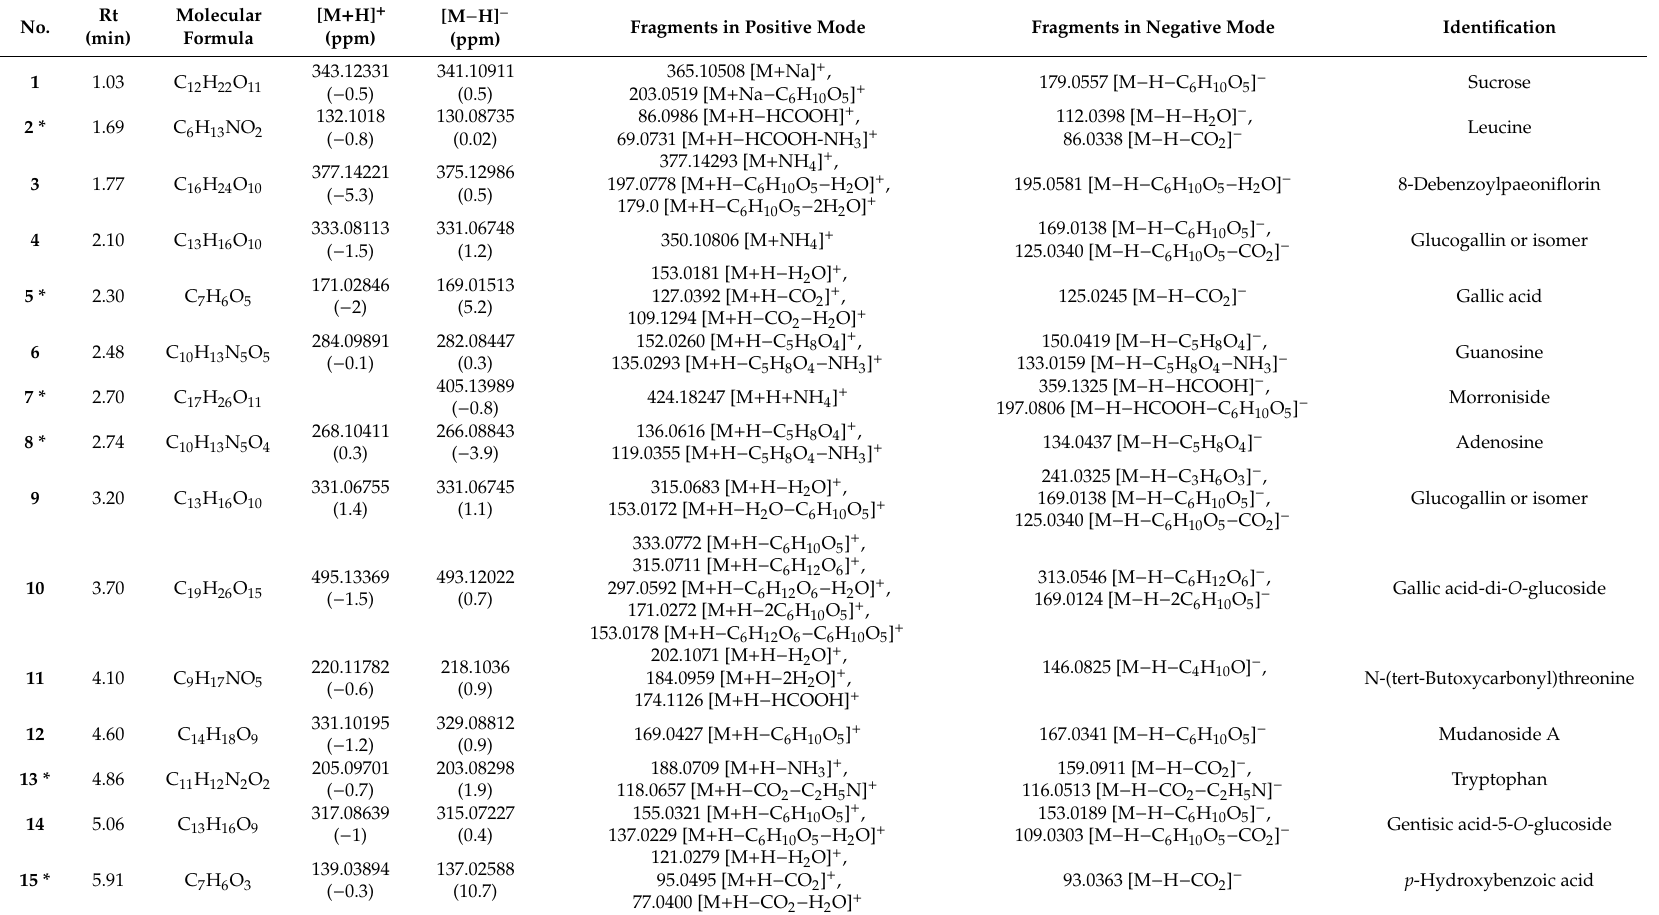
Table 2. The compounds identified in the ethanolic extracts of Paeonia su ff ruticosa flowers by